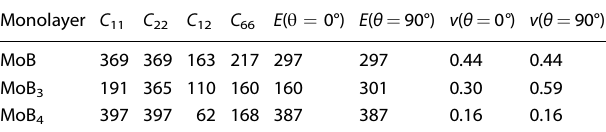
Table 2. In-plane elastic constants (N m − 1 ), Young ’ s modulus (N m − 1 ), and Poisson ’ s ratio.